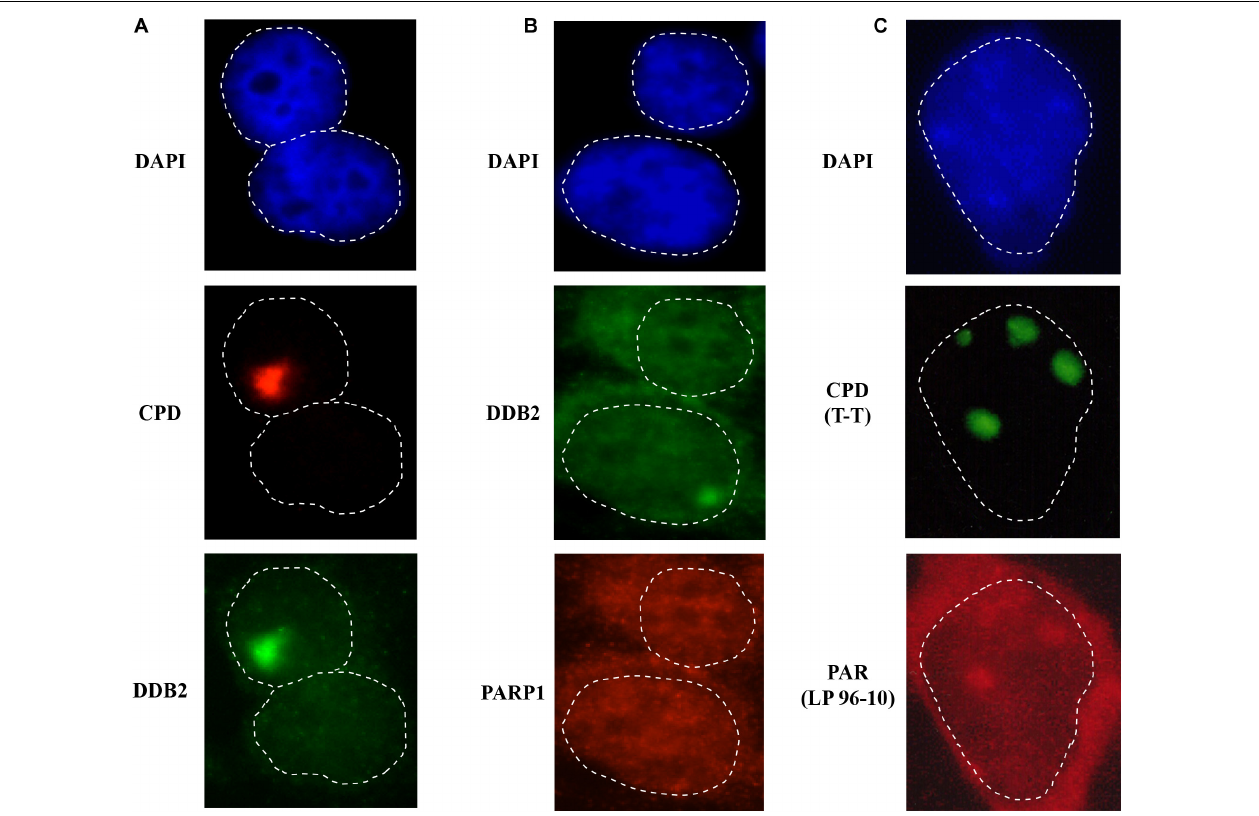
FIGURE 3 | Detection of early NER proteins at the site of damage. GMU6 human skin fibroblasts were locally irradiated with 100 J/m 2 through 5 µ m pores filter, fixed after 10 min and processed for immunofluorescence labeling for CPD and DDB2 (panel A ) or DDB2 and PARP1 (panel B ). (C) PAR formation at local damage site. GMU6 were fixed with TCA-ethanol at 15 sec after local irradiation and probed for PAR and CPD using the specific antibodies. DAPI staining was carried out to define the nuclei. Note that the cytoplasmic leakage of signal for proteins or PAR (panels B,C ) is caused by use of the harsh chemicals, such as TCA for PAR-precipitation or methanol for membrane permeabilization. Nonetheless, the signal for these targets immobilized at lesion site remains clearly visible in the